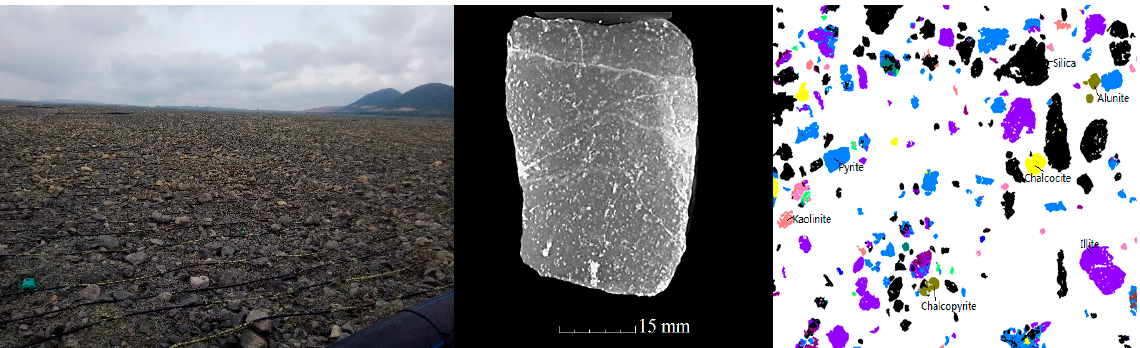
Figure 1. Ore morphology in heaps ( left ), sulfide minerals dissemination characteristics by 3D-CT tests ( middle ), and mineral composition by MLA tests ( right ).